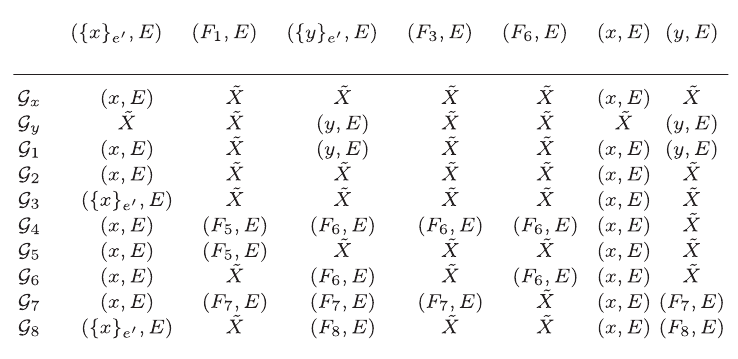
The soft convex hulls of various soft sets in the convex soft geometries defined in Example 3. See Tables 1 and 2 for